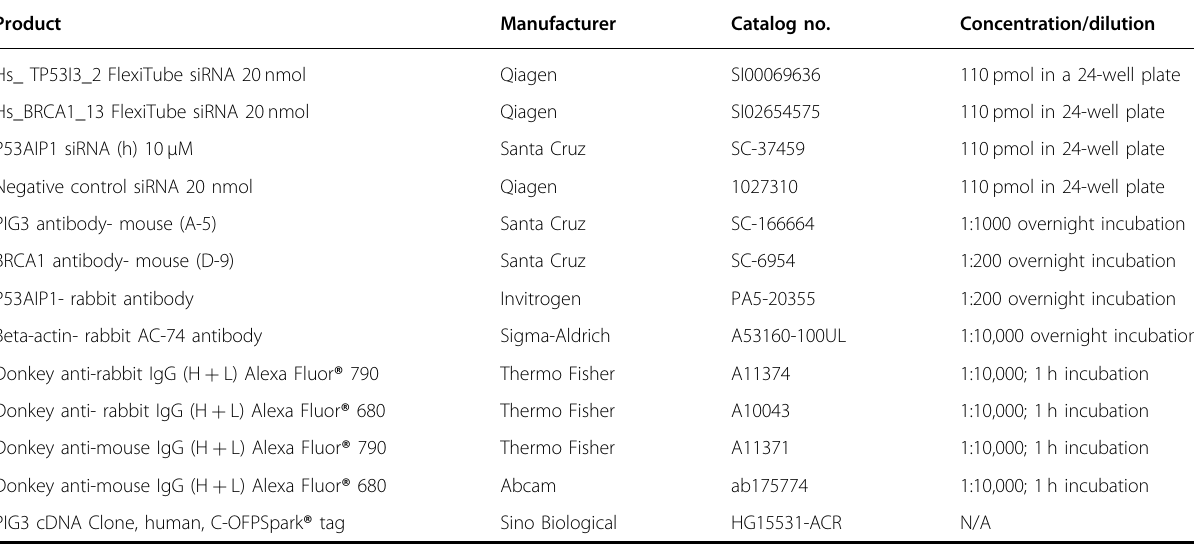
Table 2 Materials for knockdown, protein immunoblotting, and plasmid constructs.